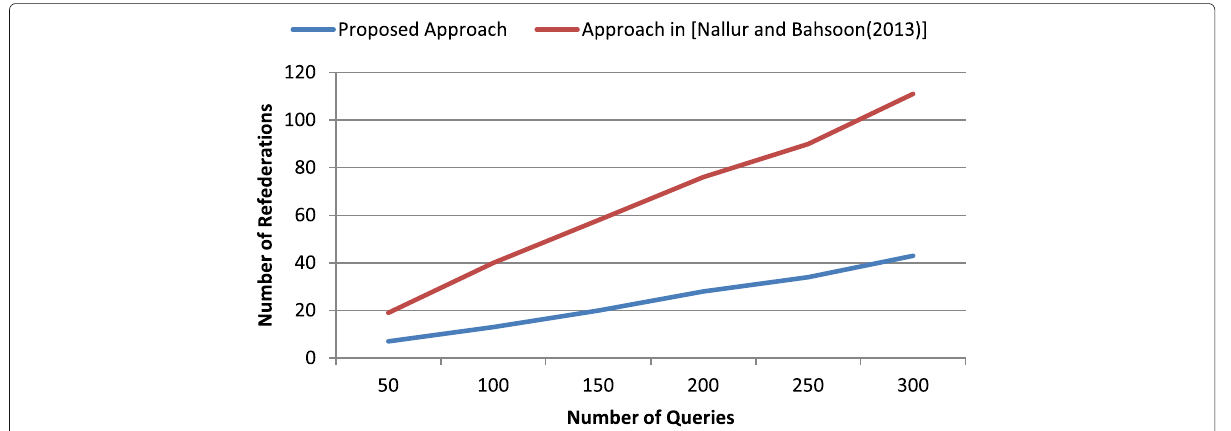
Fig. 13 Re-federation requests in case of [17] and proposed approach service requests may have such a typical demand of ser- vice QoS levels that may not be possible to readily pro- vide by the existing state of the ecosystem (federation). Here the replacement and negotiation are two mecha- nisms that help to regain the equilibrium in the ecosystem.